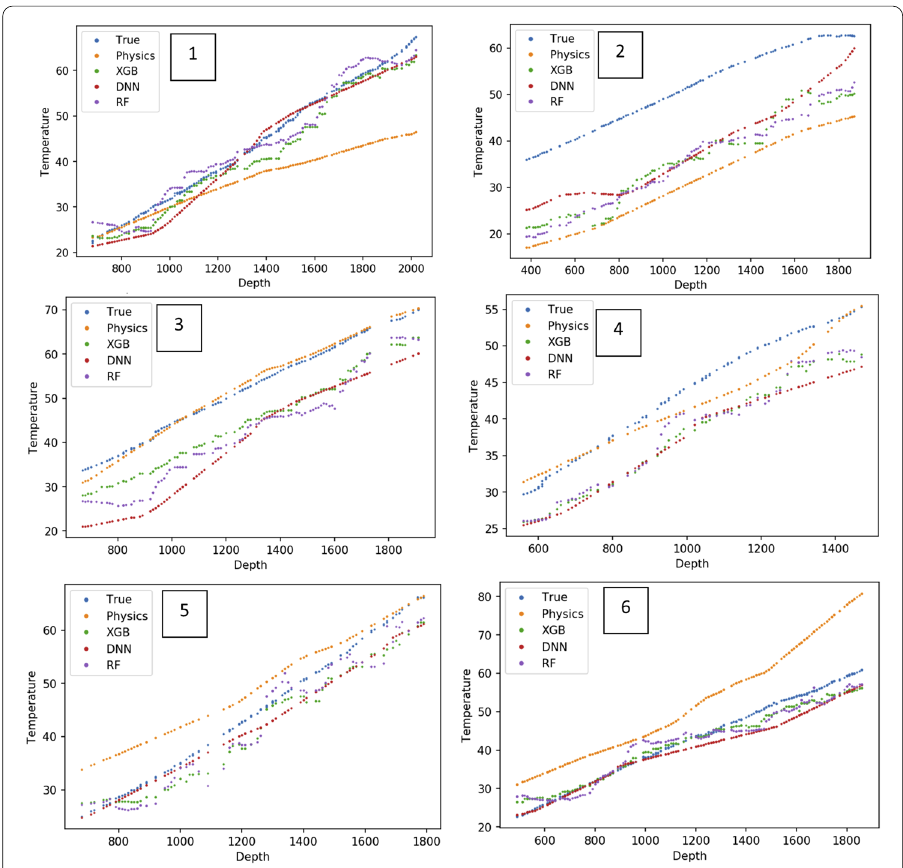
Fig. 11 Temperature-profile predictions using thermal conductivity, XGBoost and DNN models versus measured data. The units are ◦ C and m for temperature and depth, respectively